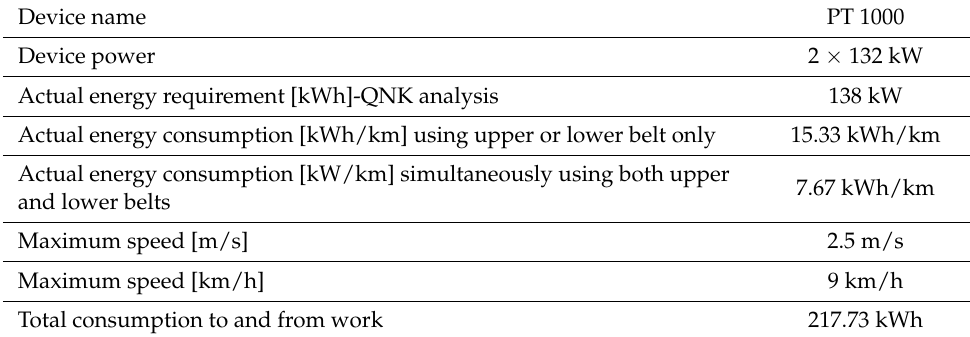
Table 4. Summary of power and energy intensity of the belt conveyor series in the analyzed